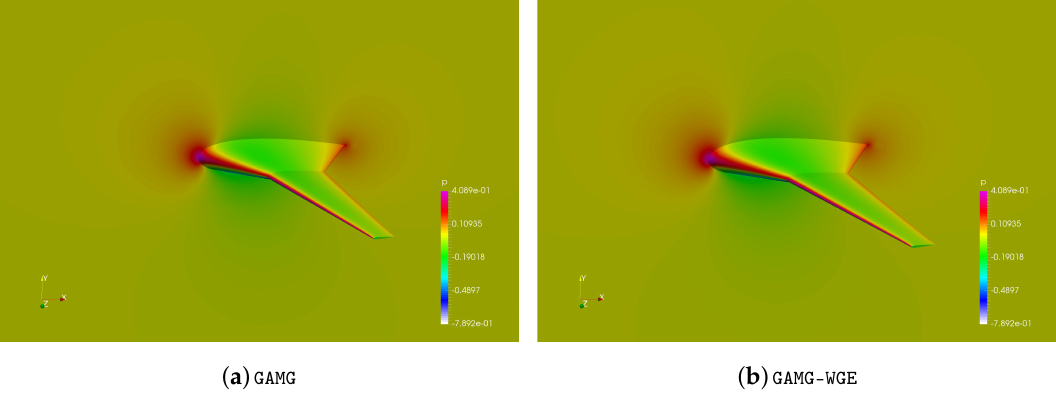
Figure 15. The distribution of p Rel field at 0.1 s using different methods in 3D blended-wing-body airfoil.